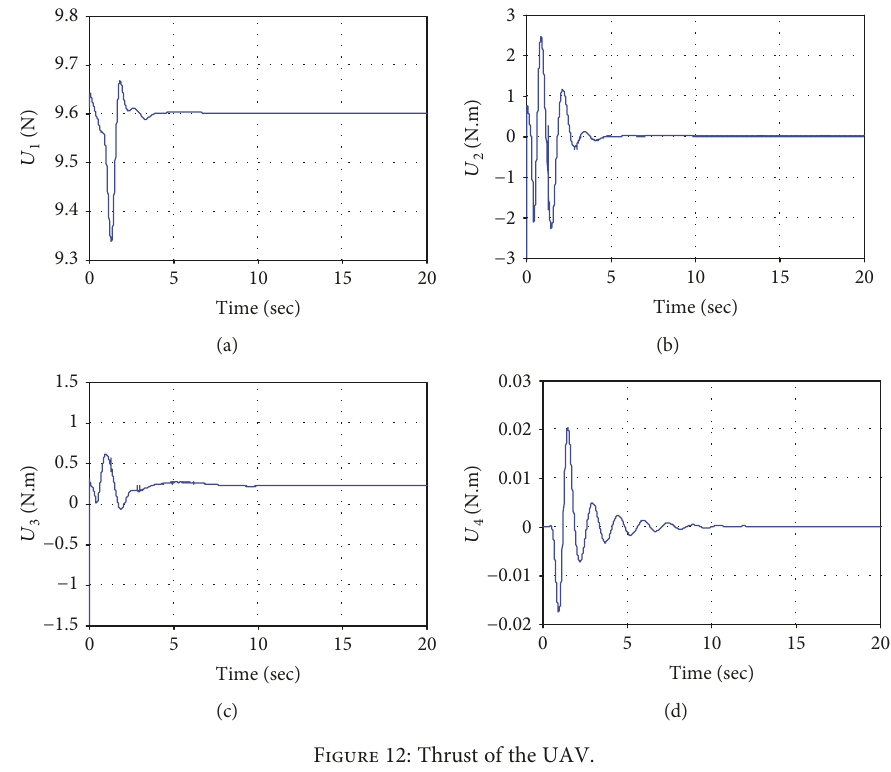
Figure 12: Thrust of the UAV.